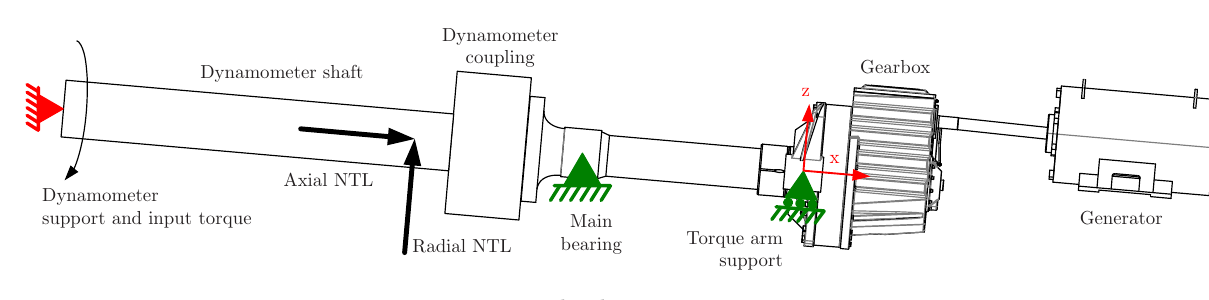
Figure 1: The dynamometer set-up